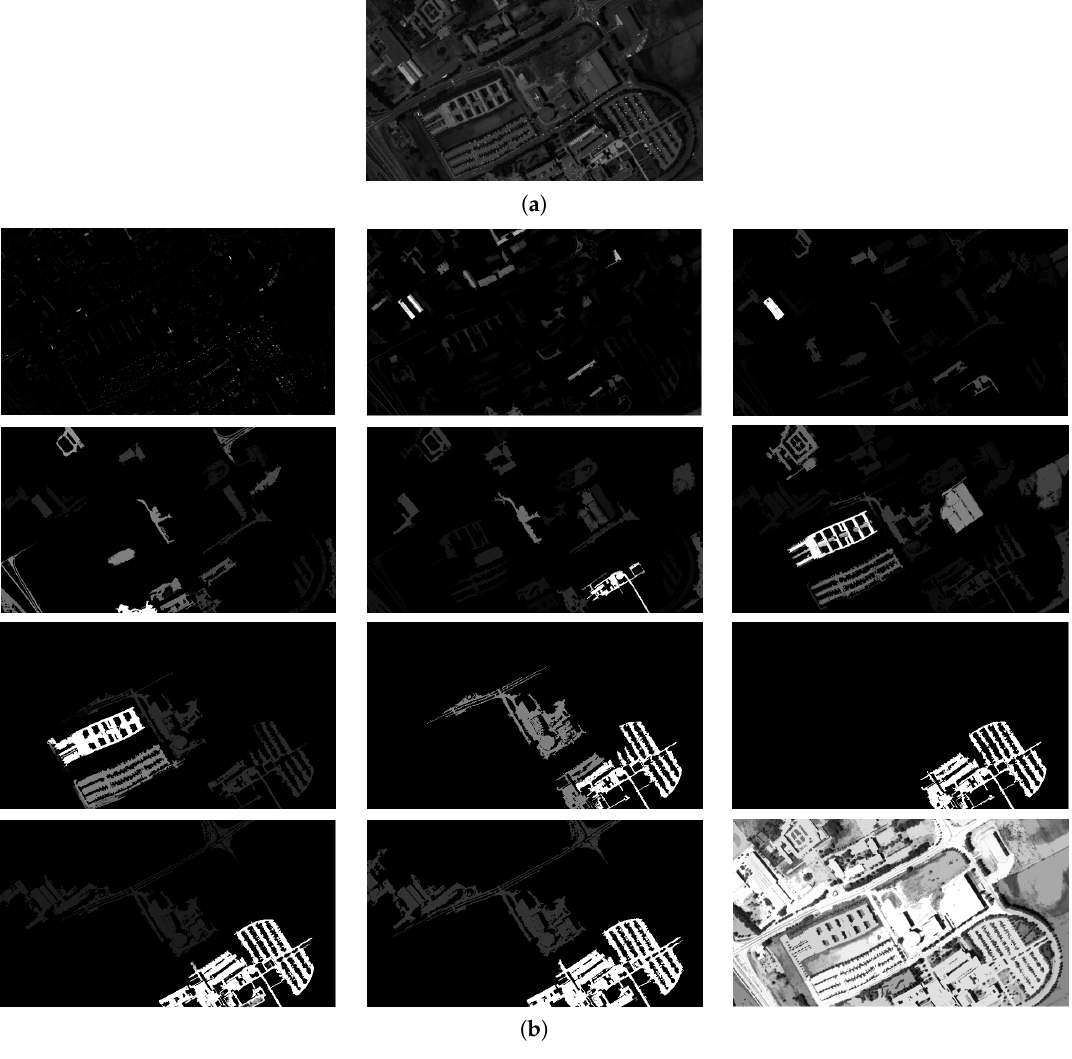
Figure 2. ( a ) Channel number 50 of Pavia hyperspectral image and ( b ) its morphological decomposition by area openings g a s , s l = f 0.5 (cid:2) 10 2 ,1 (cid:2) 10 2 ,5 (cid:2) 10 2 ,7 (cid:2) 10 2 ,1 (cid:2) 10 3 ,2 (cid:2) 10 3 ,5 (cid:2) l 10 3 ,7 (cid:2) 10 3 ,1 (cid:2) 10 4 ,1.2 (cid:2) 10 4 ,1.5 (cid:2) 10 4 ,2.5 (cid:2) 10 4 g . Last image in (b) corresponds to g a s ( f ) (cid:0) g a ( f )) . Note that the contrast of images has been enhanced to the other images in (b) are ( g a s s l l (cid:0) 1 improve